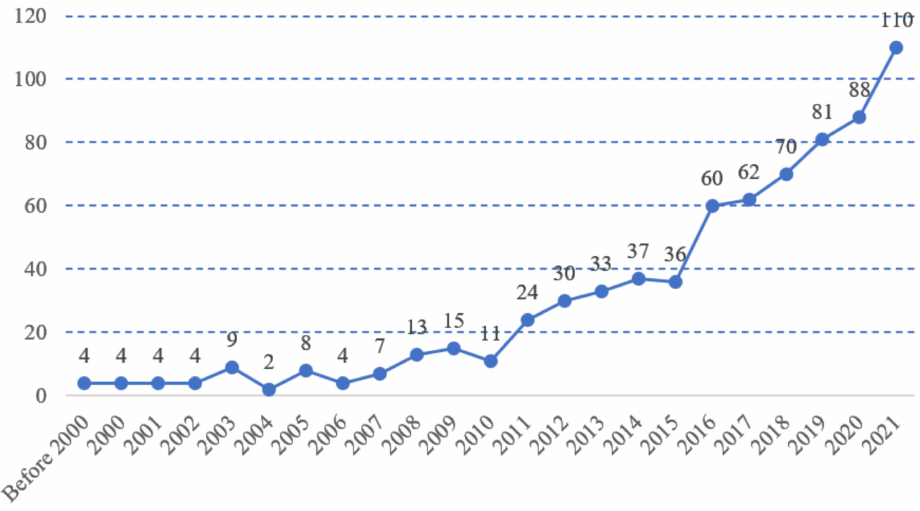
Figure 2. Line graph of SCT in Scopus in